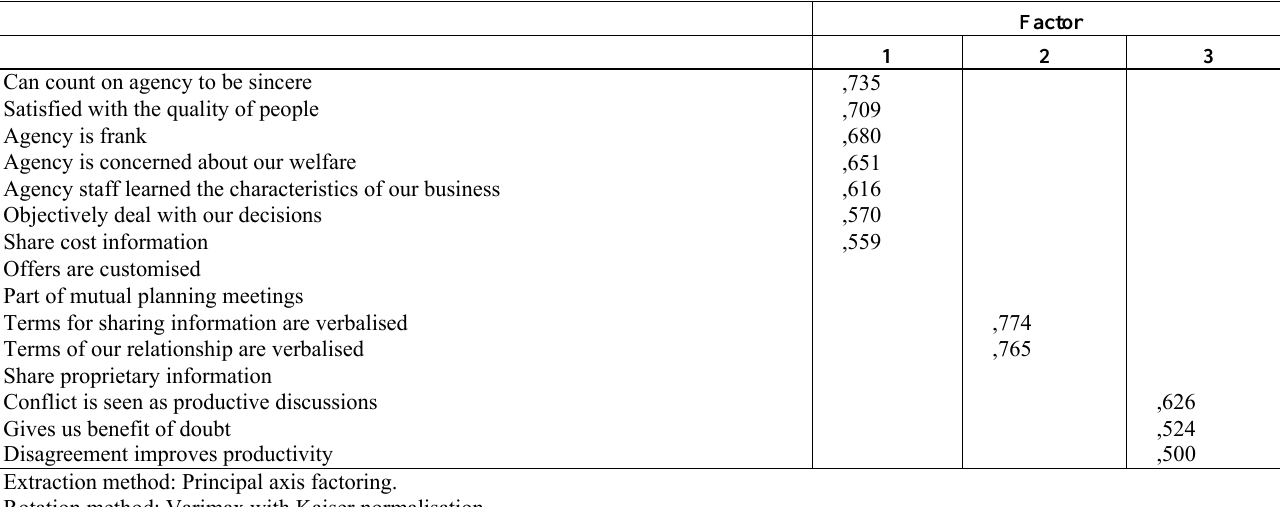
Table 4: Rotated factor matrix